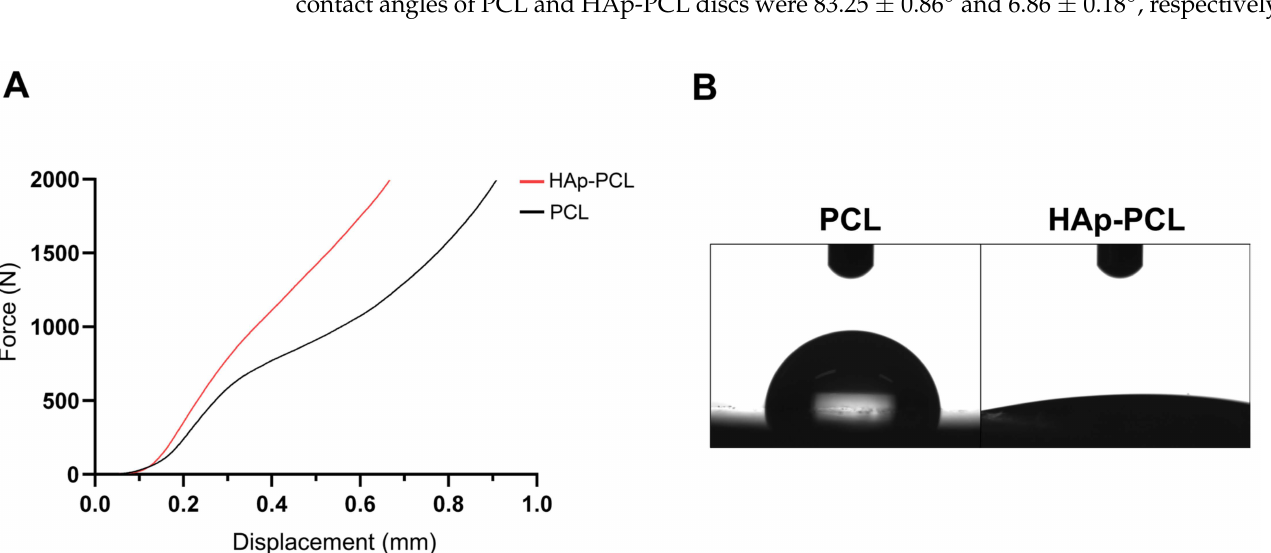
Figure 1. Characterization of hydroxyapatite coating onto PCL porous scaffold by Er: YAG PLD